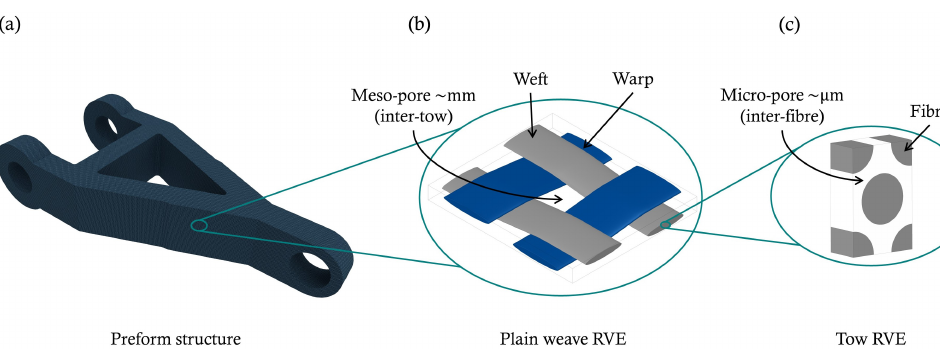
Figure 5. Multi-stage upscaling models and dual-scale pores in a preform structure: ( a ) global (macro) level; ( b ) tow level; and ( c ) fibre